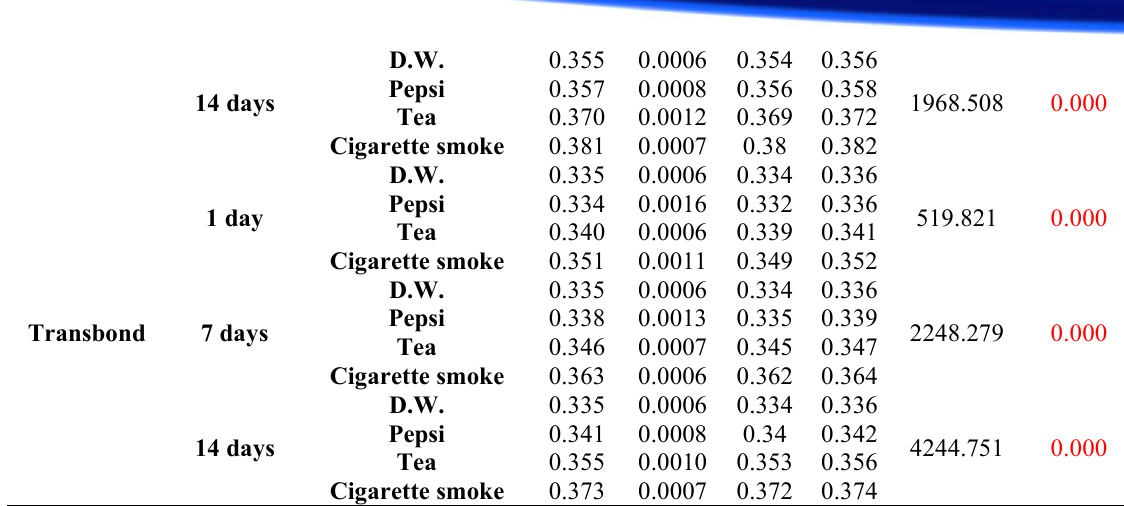
Table 2: Difference in the amounts of light absorption according to the staining materials of brackets bonded with Enlight, Resilience and Transbond adhesives. Adhesive